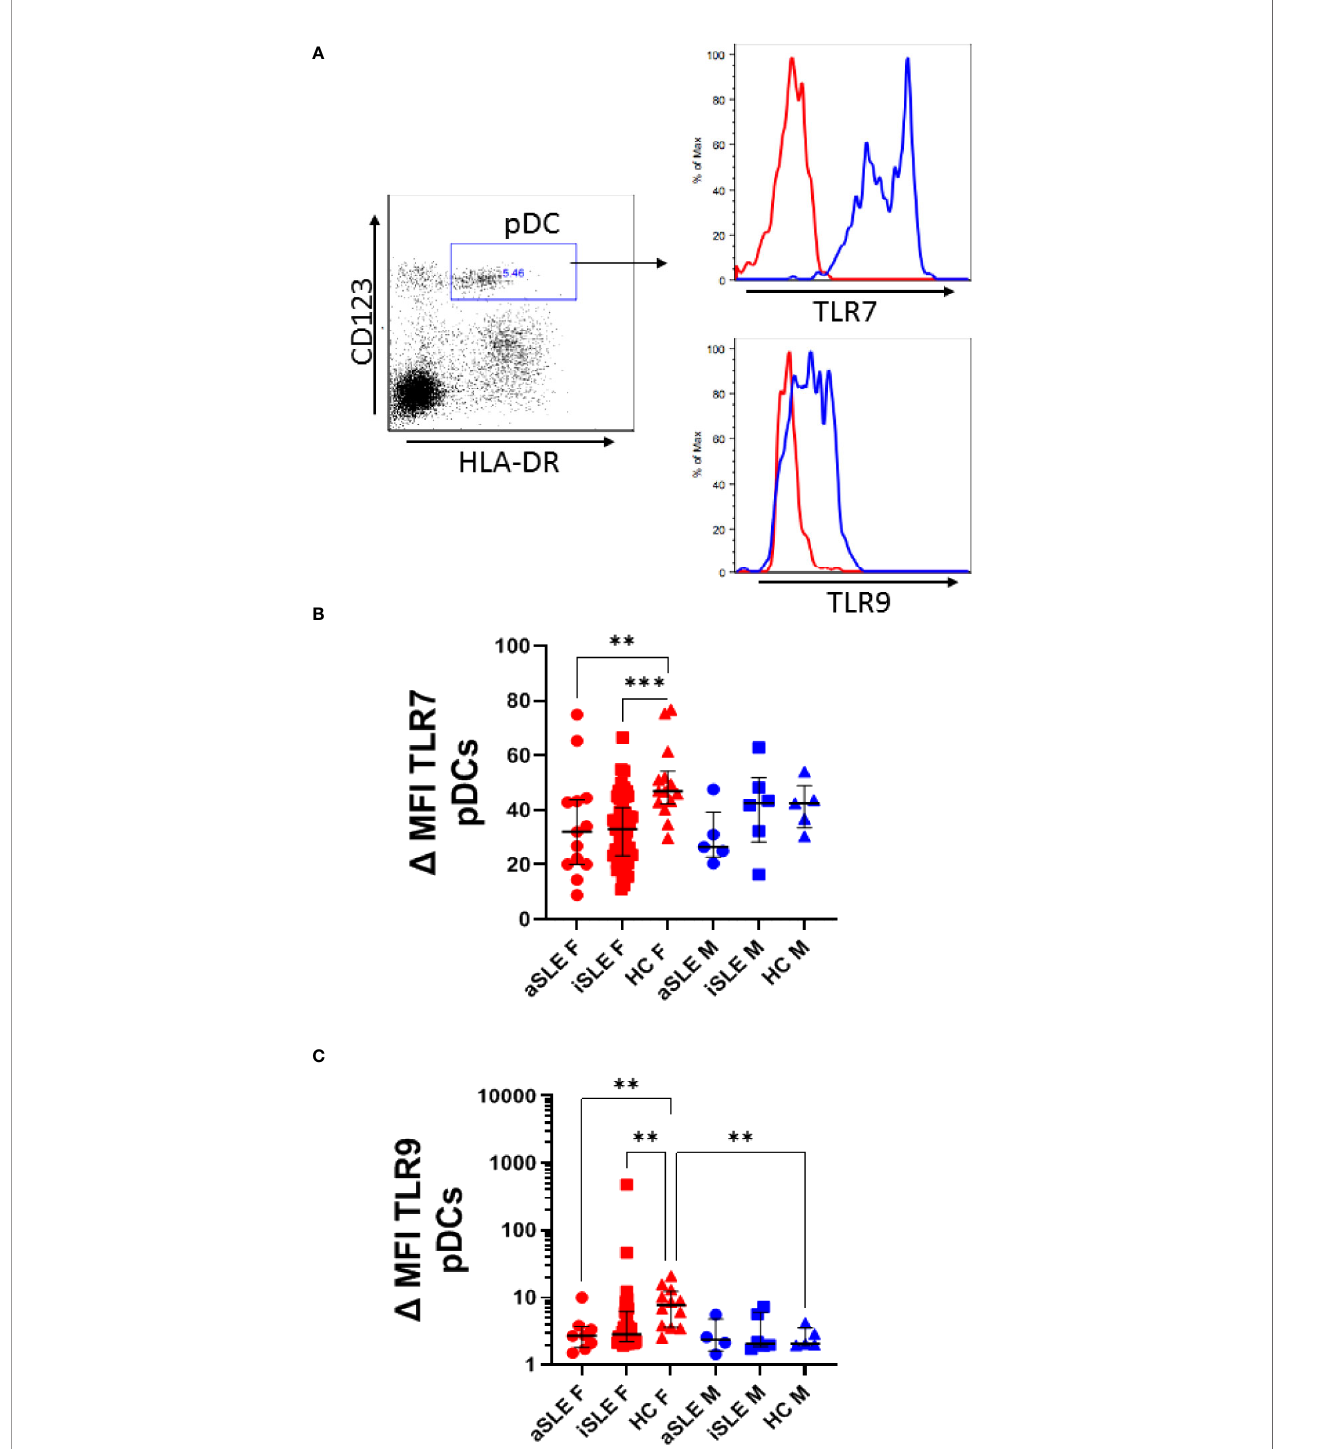
FIGURE 3 | TLR7 and TLR9 are downregulated among pDCs in SLE. A subset of PBMCs were fi xed and permeabilized and stained for intracellular TLR7 and TLR9 expression in pDCs. Mean fl uorescent intensity was measured and normalized to isotype controls (shown in red) (A) SLE patients showed decreased change in MFI in (B) TLR7 and (C) TLR9. Comparisons were made using Kruskal-Wallis Test with Dunn ’ s test for multiple comparisons. Bars represent median and interquartile range. aSLE F (N = 8), iSLE F (N = 30), HC F (N = 12), aSLE M (N = 4), iSLE M (N = 6), and HC M (N = 5). **p < 0.01; ***p <